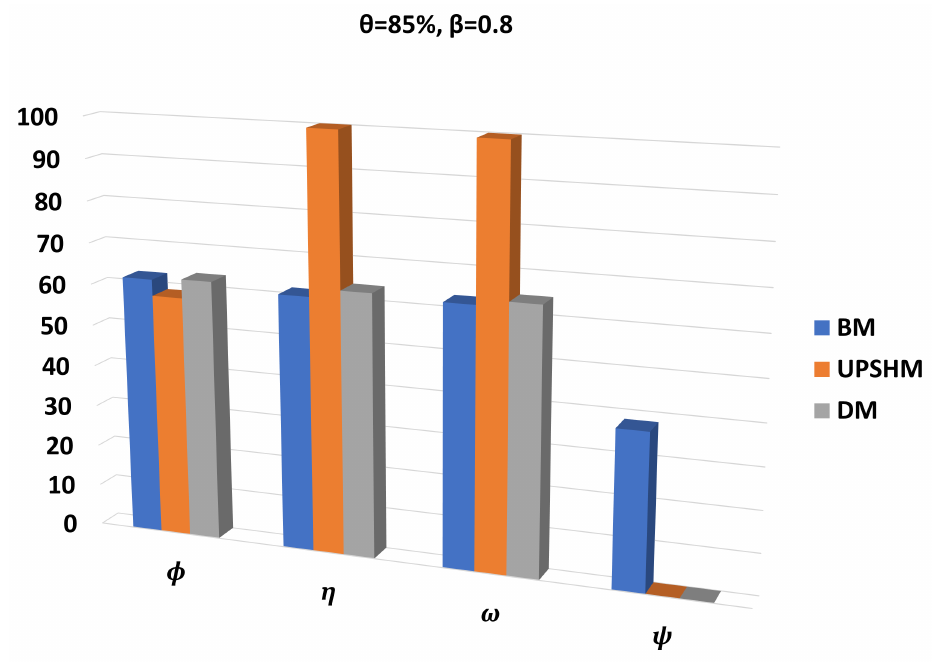
Figure 3. Comparison of results for all performance metrics, for θ = 85% and β = 0.8